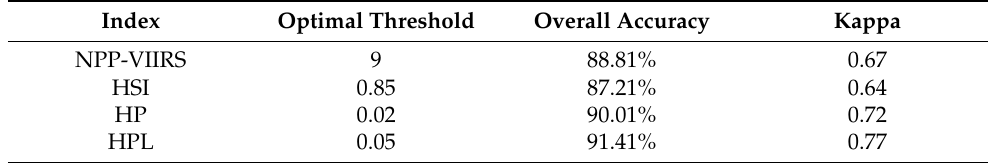
Table 2. HSI, HP, and HPL indices’ OA and kappa